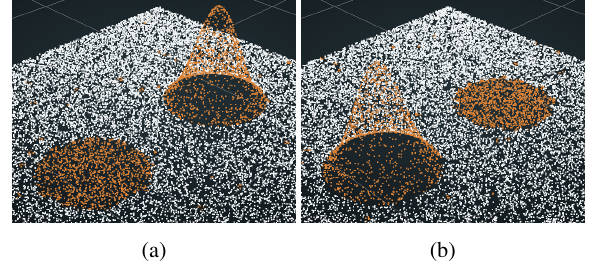
Figure 5. The point clouds representing two Gaussian surfaces with different peaks.